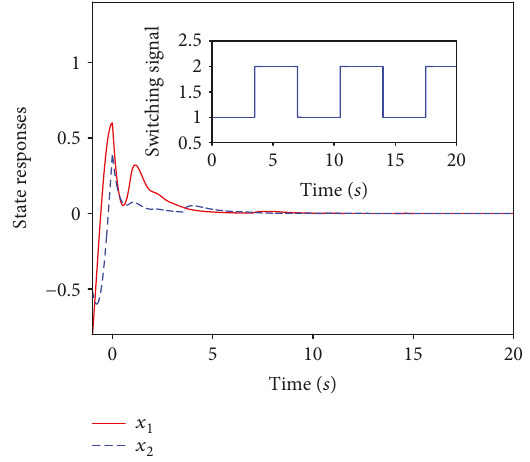
Figure 12: State responses of the considered SNNs for Example 2 with average dwell time T